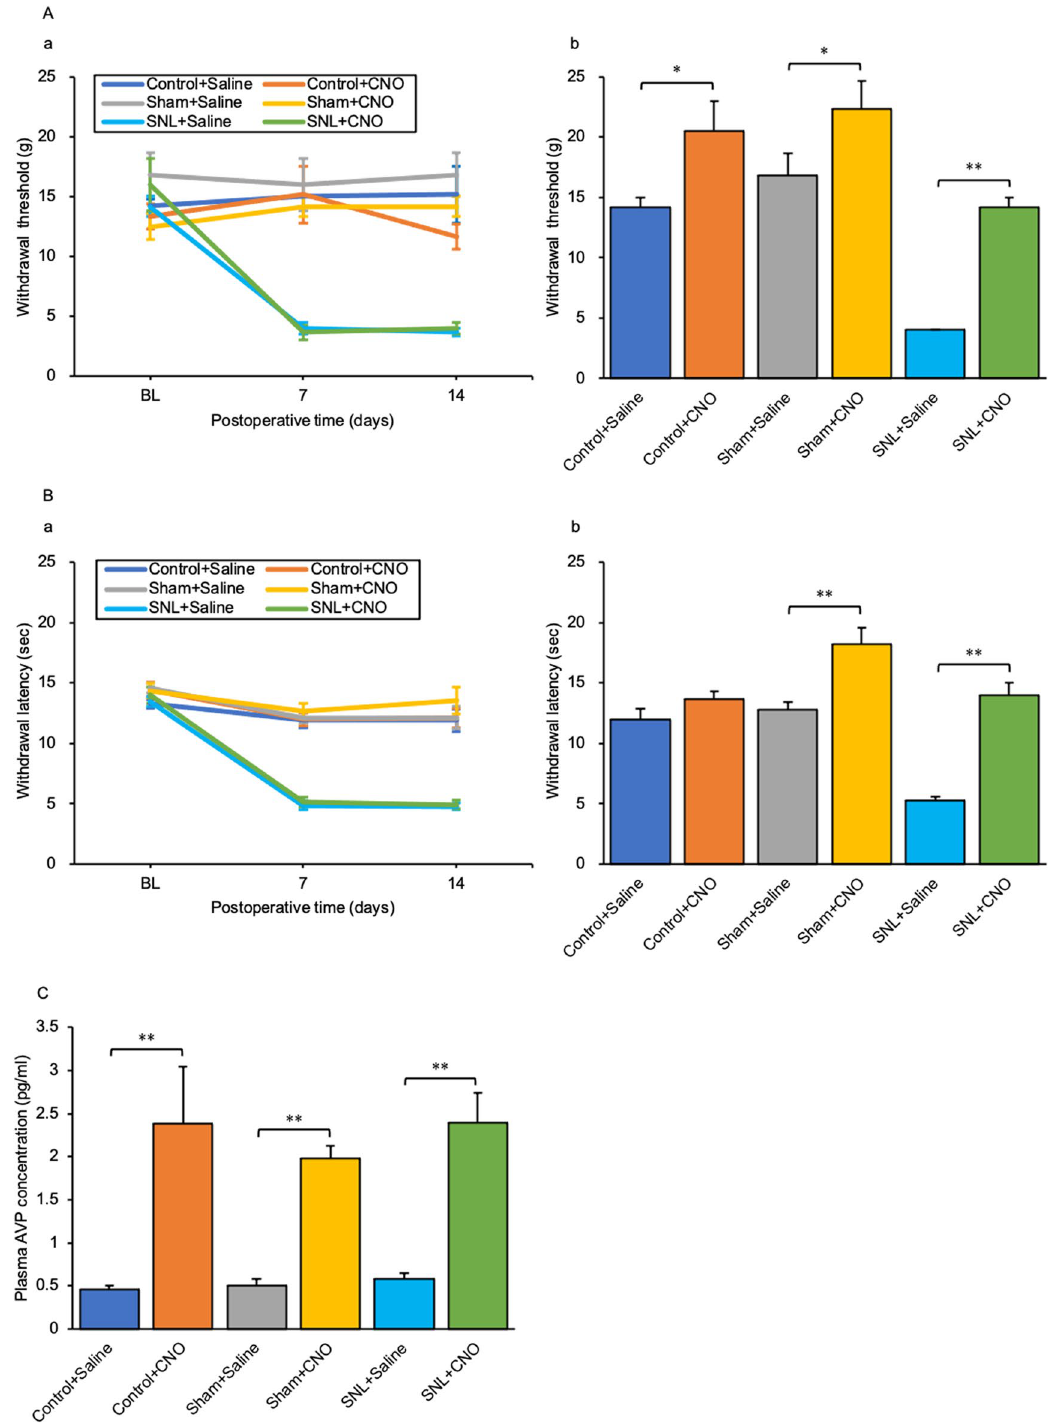
Figure 4. Mechanical and thermal nociceptive thresholds were elevated at 90 min after CNO administration in AVP-hM3Dq-mCherry Tg rats. Changes in ( A ) ( a ) mechanical and ( B ) ( a ) thermal nociceptive thresholds after the SNL procedure. ( A ) ( b ) Mechanical nociceptive threshold 90 min after CNO or saline intraperitoneal (i.p.) injection in each group. ( B ) ( b ) Thermal nociceptive threshold 90 min after CNO or saline i.p. injection in each group. ( C ) Plasma arginine vasopressin (AVP) concentration. Data are presented as the mean ± SEM (Student’s t -test). n = 6 per group. * p < 0.05 and ** p < 0.01 compared with each Saline